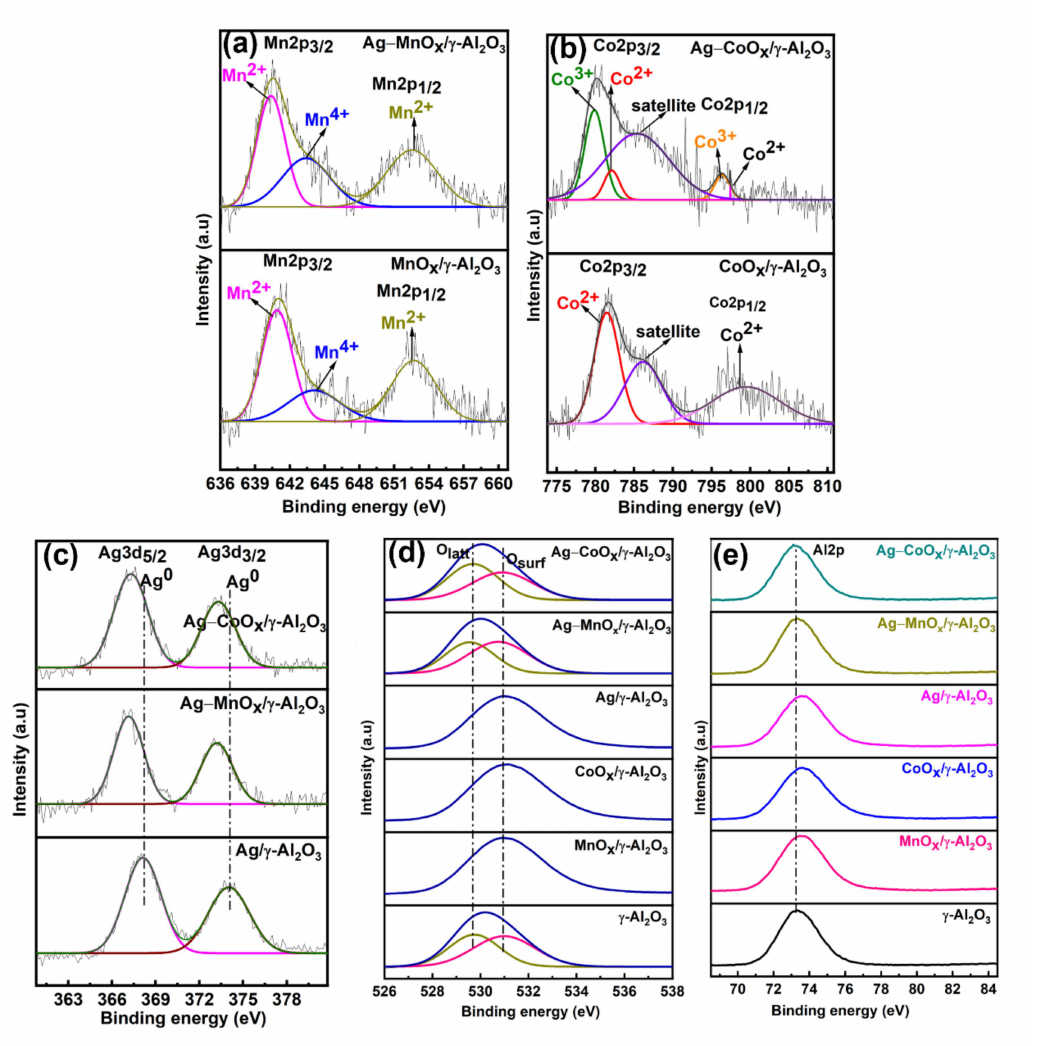
Figure 4. XPS spectra of the prepared catalysts ( a ) Mn2p, ( b ) Co2p, ( c ) Ag3d, ( d ) O1s and ( e )